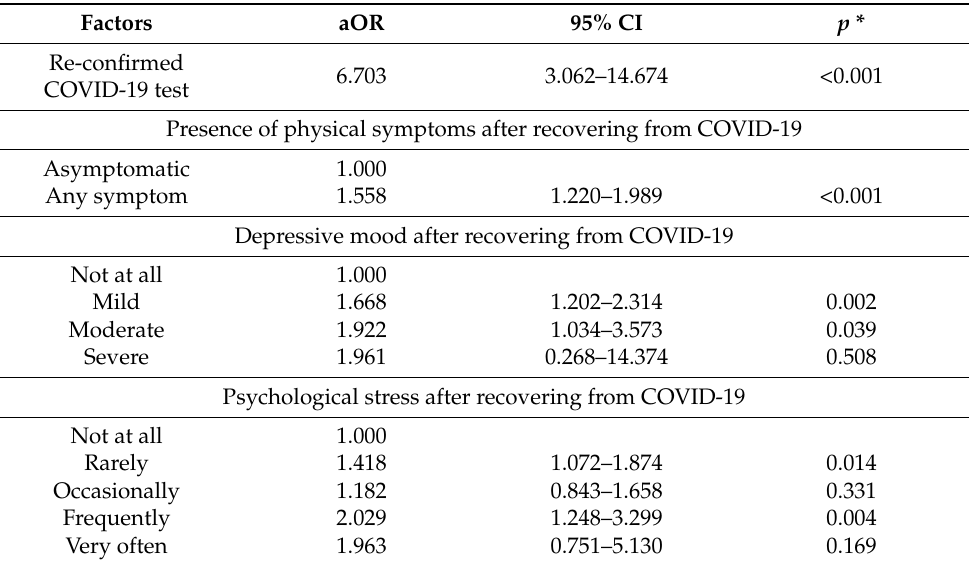
Table 3. Factors affecting the decision to request more than two consultations after recovering from